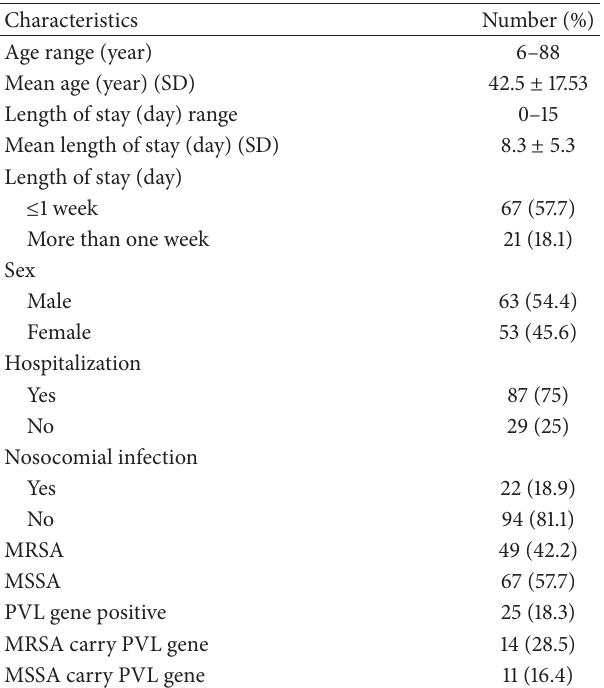
Table 1: Demographic information of S. aureus infection of pem- phigus patients in this study.